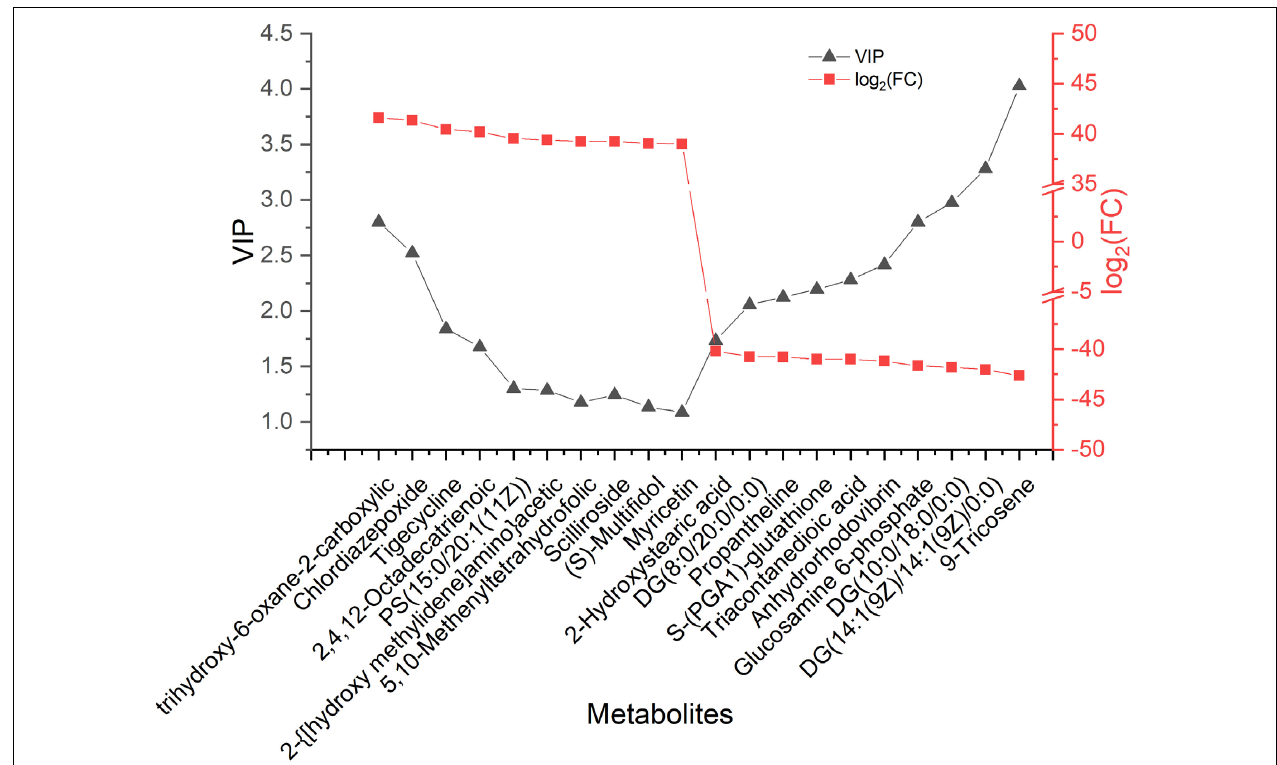
FIGURE 5 | Point diagram of 20 differentially expressed metabolites in the comparison of NLQS with VQS in the honeybee Apis mellifera . The gray points represent variable importance in the projection (VIP) values, and red points represent log 2 (fold change, FC) values. The metabolites in the left half were high, whereas those in the right half were low concentration in new-laying queen spermatheca compared with those in virgin queen